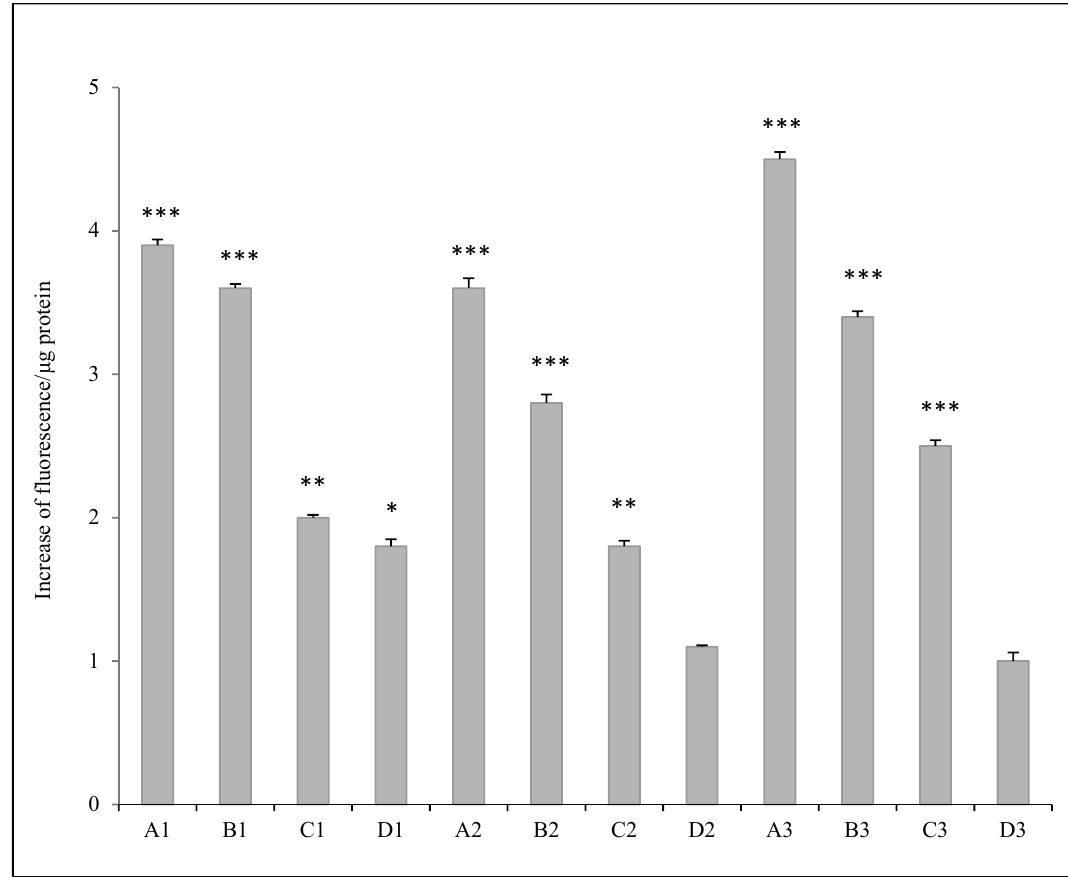
Figure 3. ROS expression in H727 cells treated for 3 h, with different environmental solution. A = Fraction 2.5–10 µm; B = Fraction 1–2.5 µm; C = Fraction 0.5–1 µm; D = 0.25–0.5 µm. Site 1 = platform; Site 2 = commercial-intermediate area; Site 3 = outdoor. * p < 0.05, ** p < 0.01, *** p < 0.001 vs. untreated cells